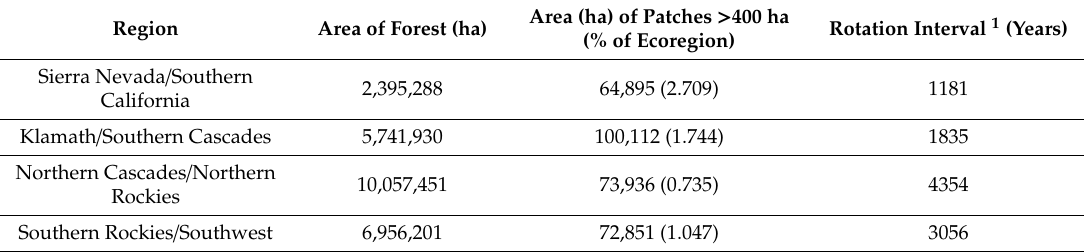
Table 3. Total area and fire rotation interval for occurrence of CESF patches > 400 ha in the four regions of the study area from 1984 to 2015.